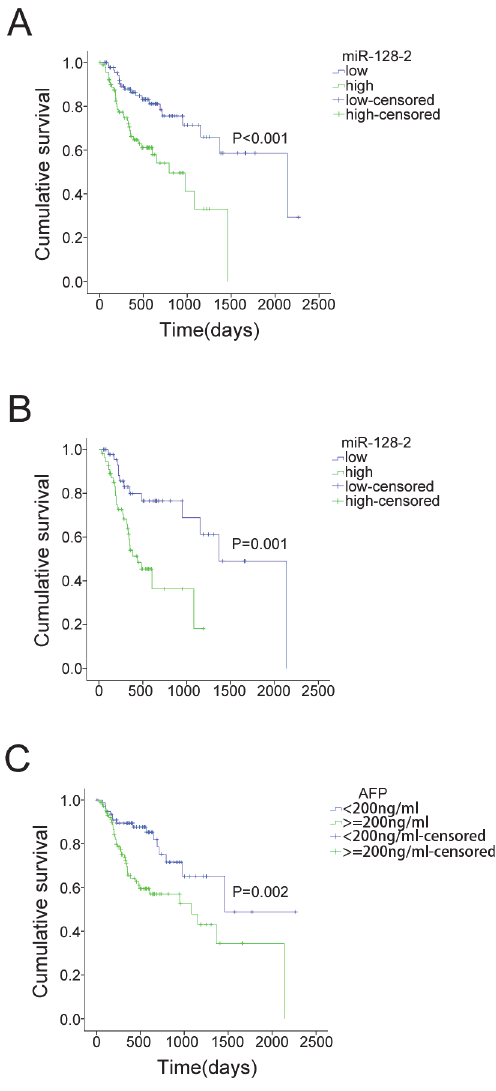
Fig 1. Kaplane Meier curves for different subsets of patients. A . Kaplane Meier curve for overall survival in a cohort of 182 HCC patients grouped by the serum level of miR-128-2. The serum miR-128-2 level was analyzed by TaqMan real-time qPCR, and the median miR-128-2 expression level was chosen as the cut-off point for separating the miR-128-2 low-level cases (n = 91) from the miR-128-2 high-level cases (n = 91). Low level of serum miR-128-2 was associated with better survival. B. Low level of serum miR-128-2 was still related with better survival in the subset of patients with serum level of AFP higher than 200ng/ml. C. Patients with serum level of AFP lower than 200ng/ml present better survival in comparison with patients with AFP level higher than 200ng/ml.